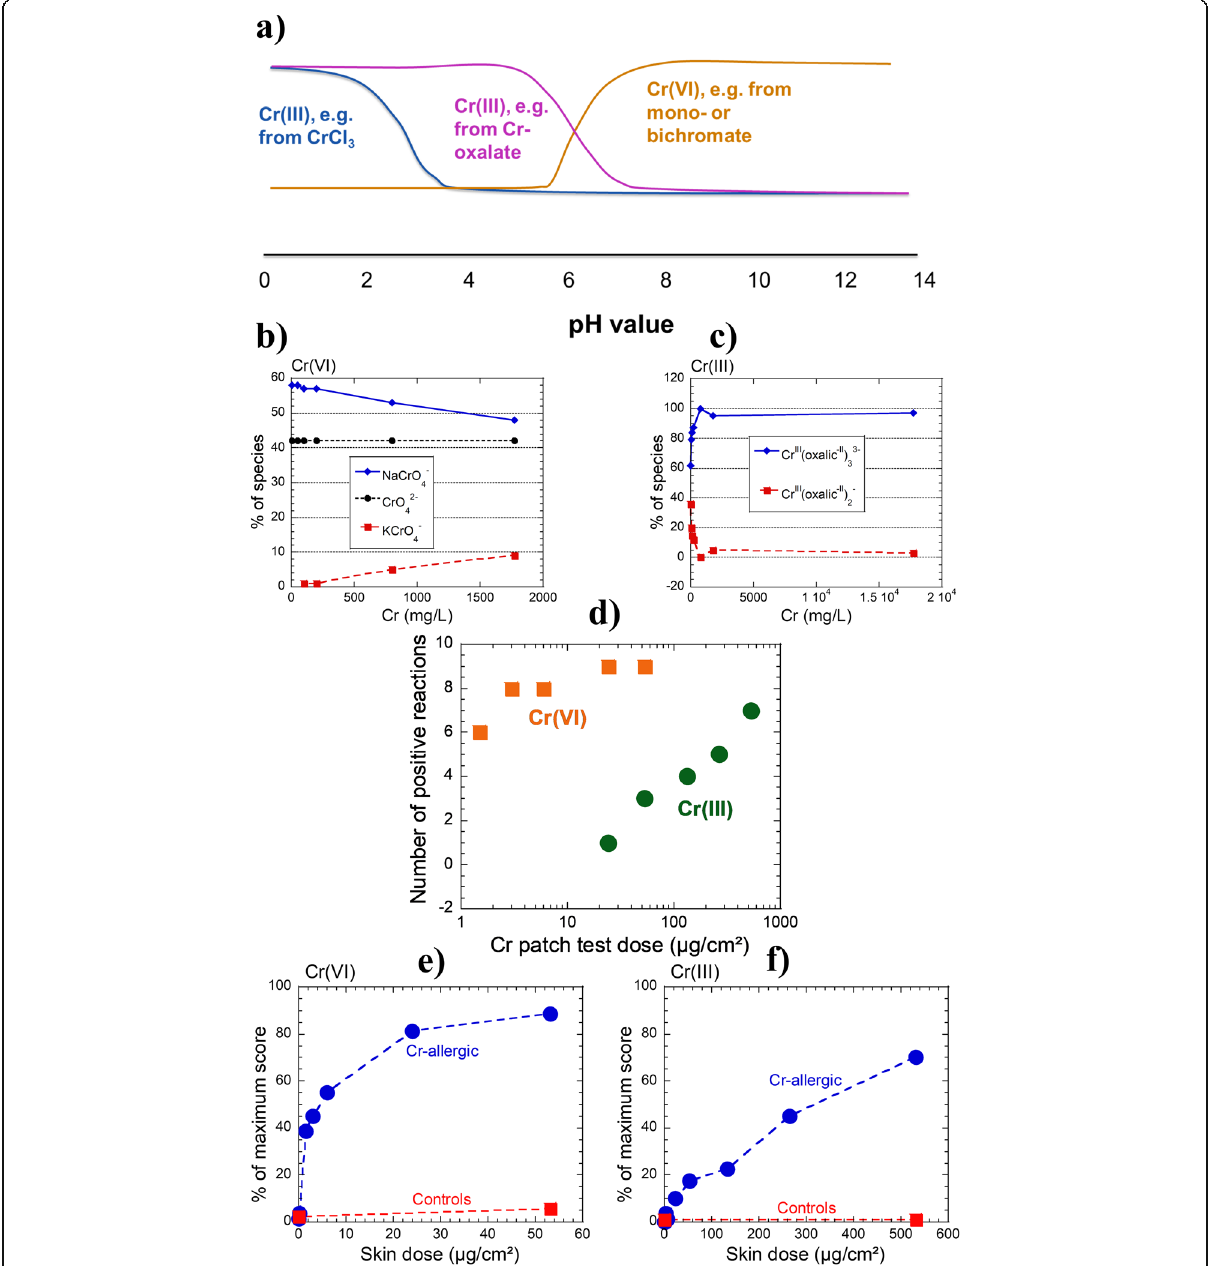
Fig. 2 Schematic overview on chemical speciation of different trivalent and hexavalent chromium species as a function of pH ( a ), calculated chemical speciation of hexavalent chromium from a dichromate salt at pH 8.5 ( b ) and of trivalent chromium from a chromium(III) oxalate salt at pH 4.1 ( c ) as a function of concentration covering the range of concentrations used in the clinical patch test study [36], number of positive skin reactions in ten chromium-allergic individuals as a function of patch test dose ( d ), from [36], and severity of skin reactions, expressed as percentage of the possible maximum score, of ten chromium-allergic individuals and 22 non-allergic controls, when tested with hexavalent chromium ( e ) or trivalent chromium ( f ) in the same study. Cr – chromium; Cr(VI) – hexavalent chromium; Cr(III) – trivalent chromium; skin or patch test dose is expressed as μ g chromium species per cm 2 skin